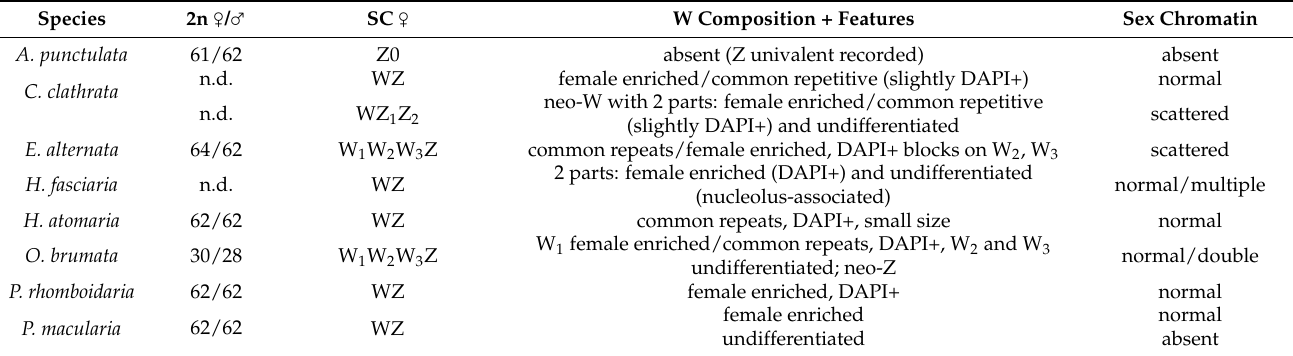
Table 1. Overview of